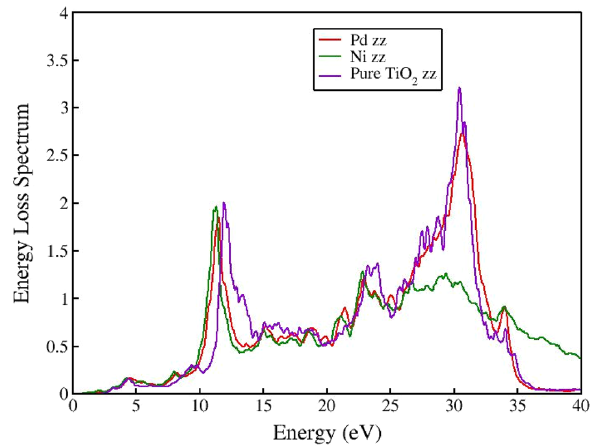
Fig. 4 Electron-energy spectrum of Ni, Pd and Pure TiO